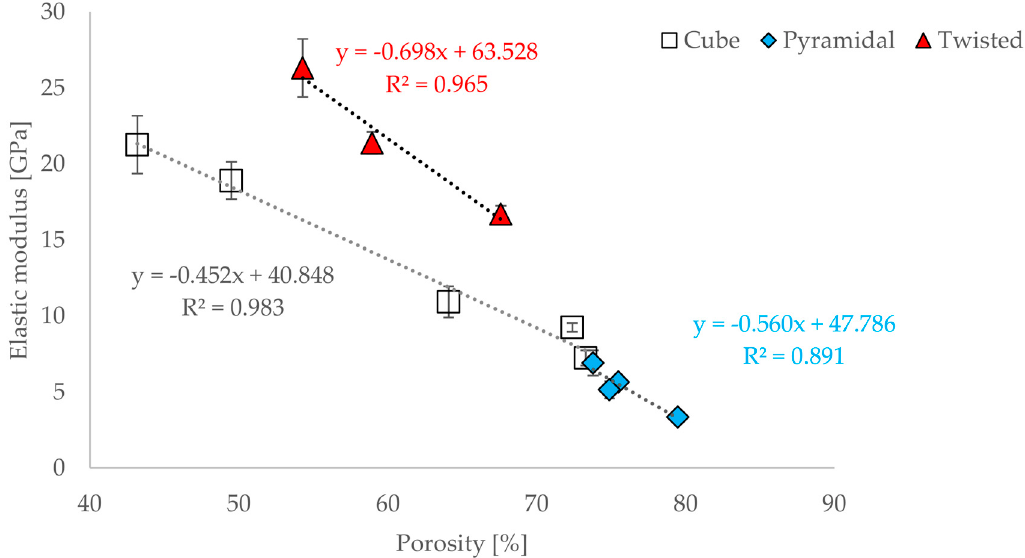
Figure 7. Correlation between porosity and elastic modulus in each of the investigated designs. Results are shown as mean values with the corresponding standard deviations. For the linear regressions, the coefficient of determination is shown.